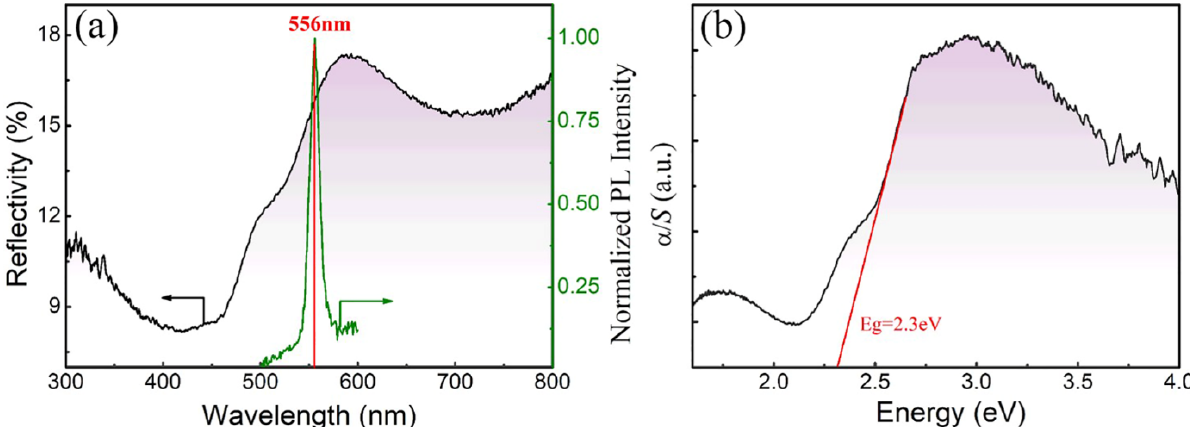
Figure 6. ( a ) Optical diffuse reflectance spectrum of the LFRO powders. Inset is a steady-state photoluminescence (PL) spectrum measured at 10 K under laser beam excitation with wavelength of 325 nm. ( b ) Plot of α /S vs. h ν curve derived from the Kubelka–Munk function.